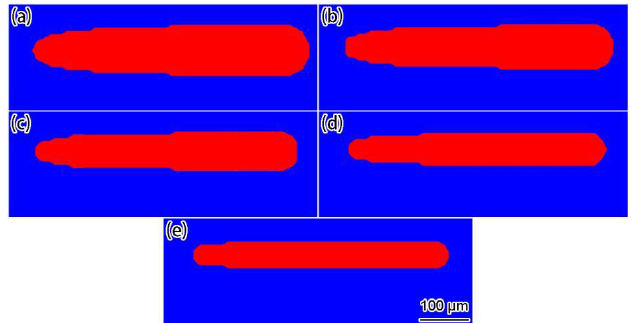
Figure 17. Simulation results of the final shapes of solidified tracks under different scanning speeds: ( a ) 0.4 m/s; ( b ) 0.5 m/s; ( c ) 0.6 m/s; ( d ) 0.7 m/s; ( e ) 0.8 m/s.